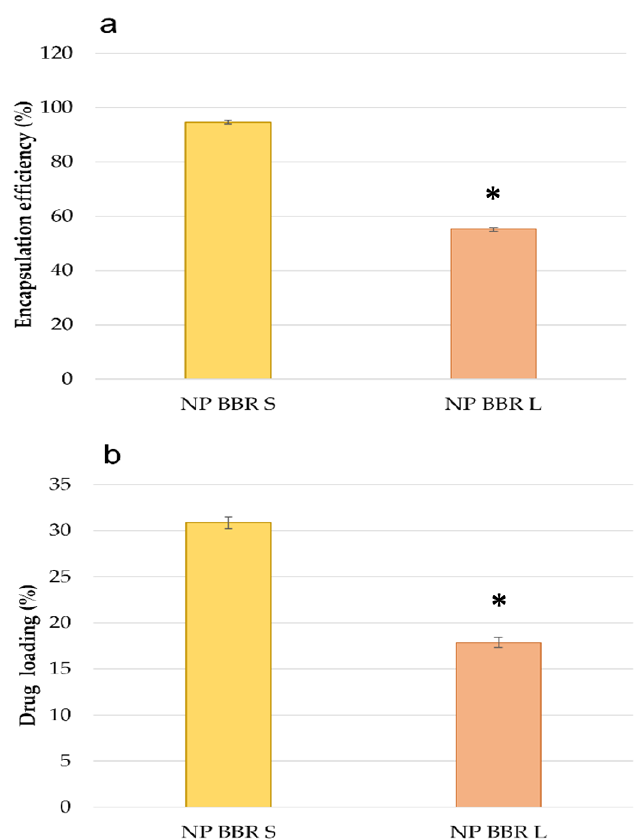
Figure 4. Encapsulation efficiency % ( a ) and drug loading % ( b ) for the NPs loaded with the two salts. Data are reported as mean values ± standard deviations ( n = 3). NP BBR S vs. NP BBR L were statistically significantly different (*) for both encapsulation efficiency and drug loading (Student’s t -test, p < 0.05).